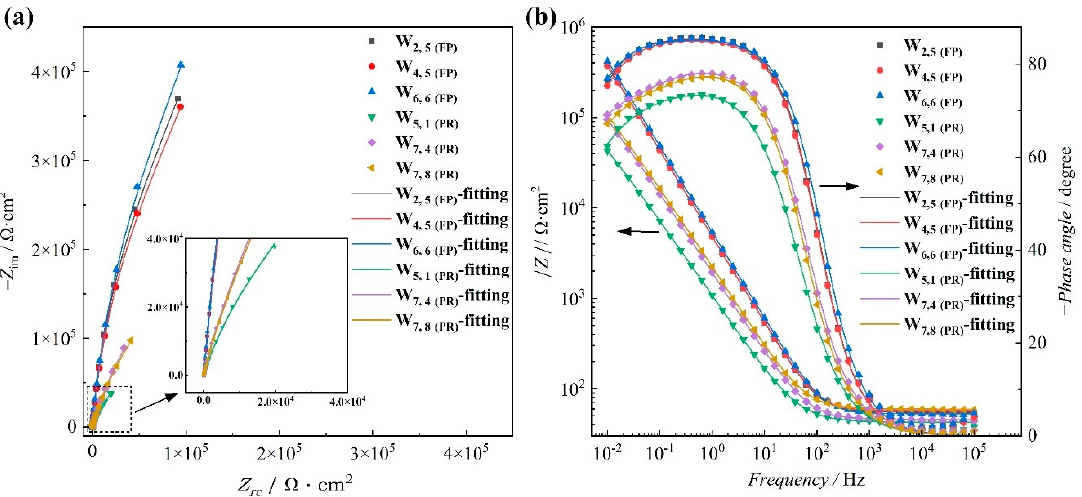
Figure 7. The Nyquist plot ( a ) and Bode plots ( b ) of six selected wires of WBE wires in carbonated SCPS.